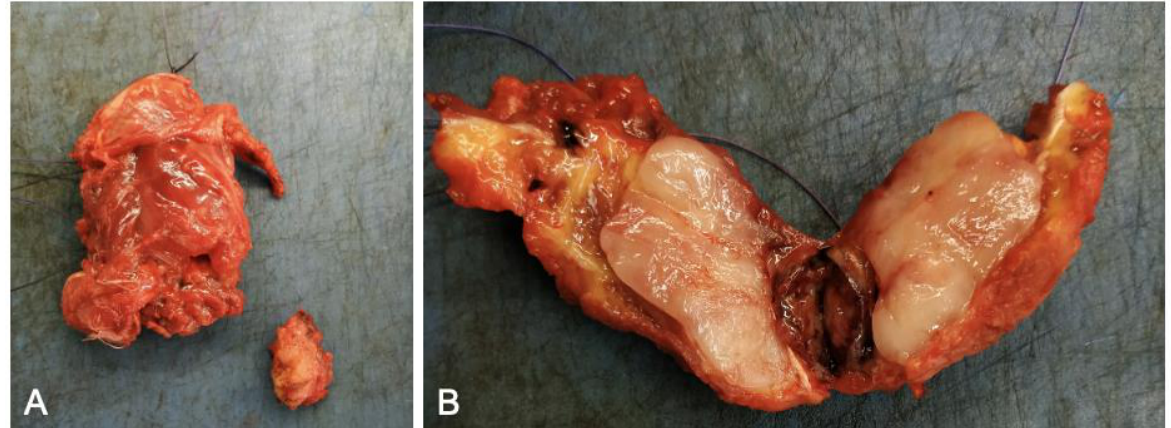
Figure 4. Macroscopic features of the lesion. ( A ) The whole mass encircled by muscle. ( B ) Longitu- dinal section area.